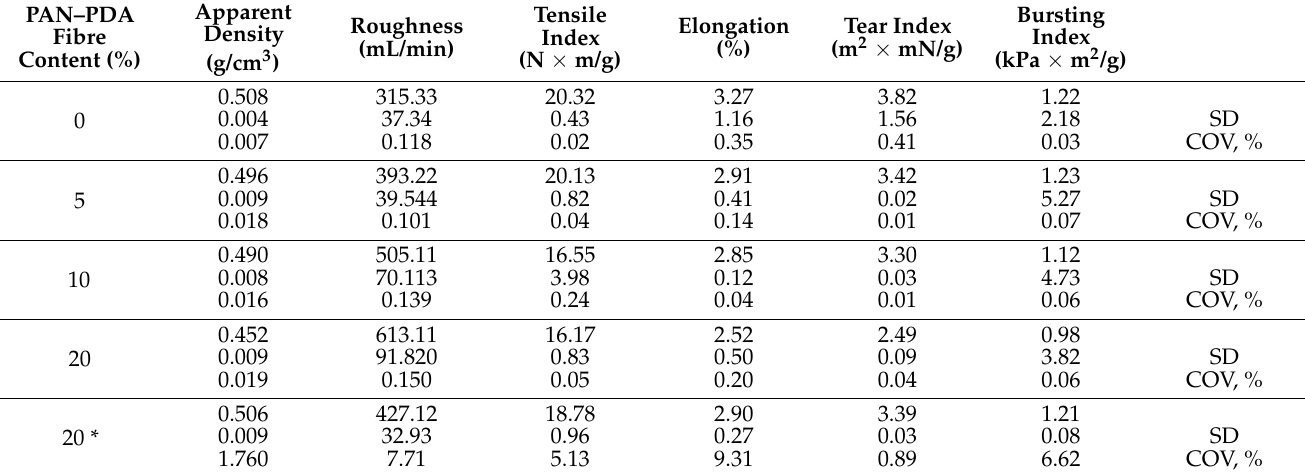
Table 3. Basic parameters of the paper samples doped with different amounts of PAN–PDA fibres (SD denotes the standard deviation and COV denotes the coefficient of